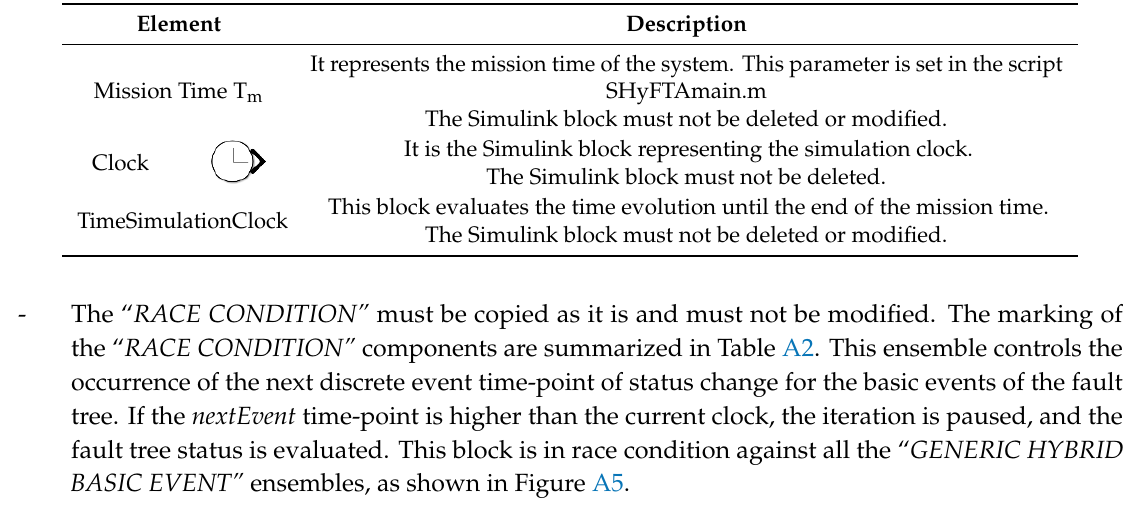
Table A2. Marking of the components of the RACE CONDITION Simulink